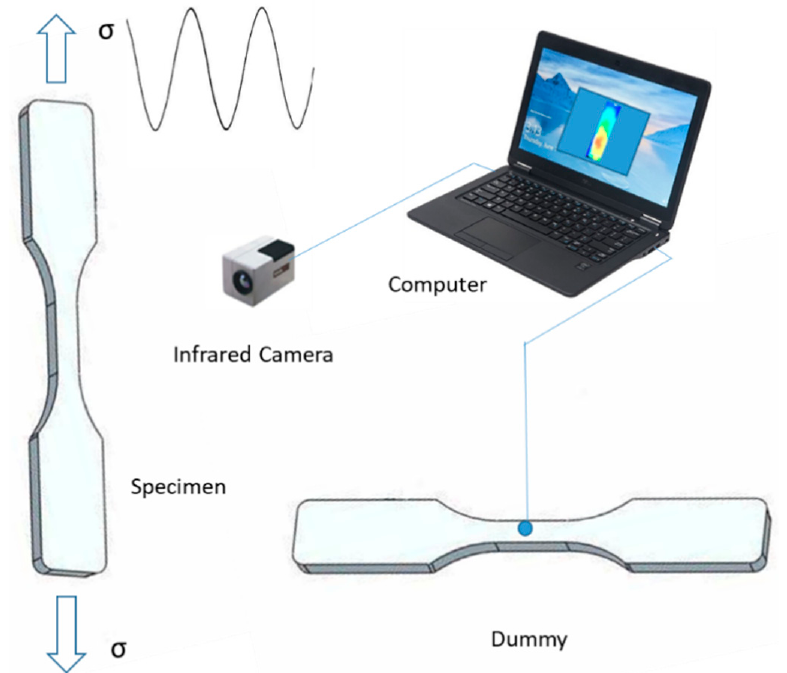
Figure 1. A schematic of the thermographic fatigue test setup.